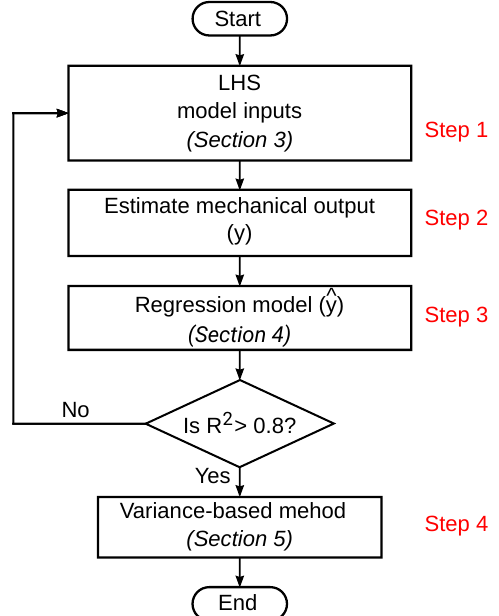
Figure 7. Flow chart for numerical estimation of the effect of the input parameters on the model